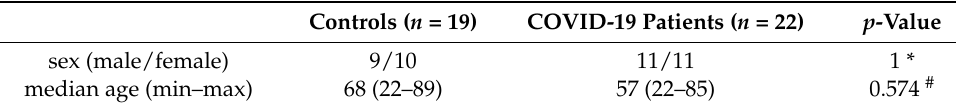
Table 1. Demographics of patients and controls.